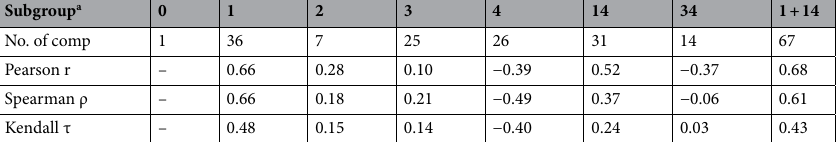
Table 1. Correlations of calculated and experimental binding free energies for the subgroups of the compounds. a The subgroups are defined using single categories (1–4) or combinations of these categories. 14, for example, is a subgroup of compounds with modifications of (1) ether variation and (4) lactam substituent variation. “1 + 14” is a subset of compounds from subgroups 1 and 14. L30 is labelled as the only member in subgroup 0. Only electrostatically neutral compounds are